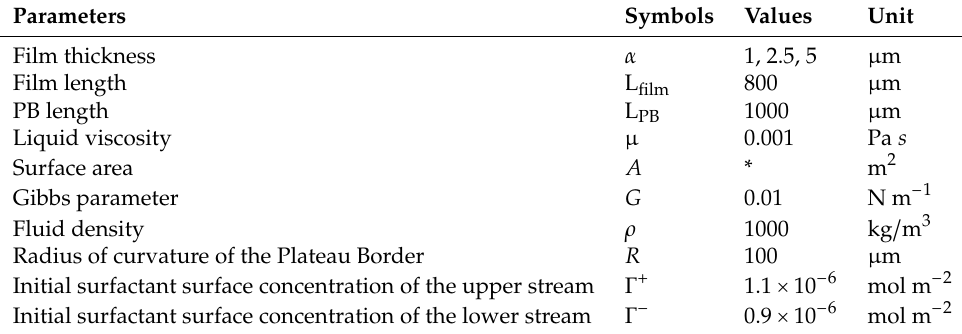
Table 1. Geometry and Simulation Parameters. The approximate Reynolds number of the flow for the chosen radius of curvature and thin films is less than 1 [28]. Hence, in most numerical studies of very dry foams, the Stokes equation is solved using the governing equation. ∗ It is noteworthy that A is the cross-section area which varies in the interior and exterior of the foam for different thicknesses. Parameters Symbols Values Unit Film thickness α 1, 2.5, 5 µ m Film length L film 800 µ m PB length L PB 1000 µ m Liquid viscosity µ 0.001 Pa s Surface area A * m 2 Gibbs parameter G 0.01 N m − 1 ρ 1000 kg / m 3 R 100 µ